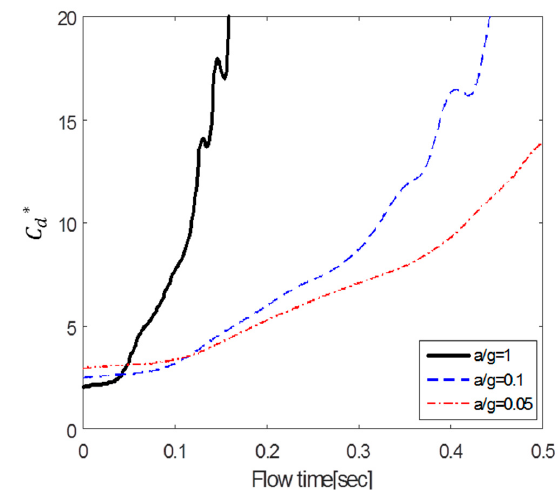
∗ ( Re ffi cient C = 0 d